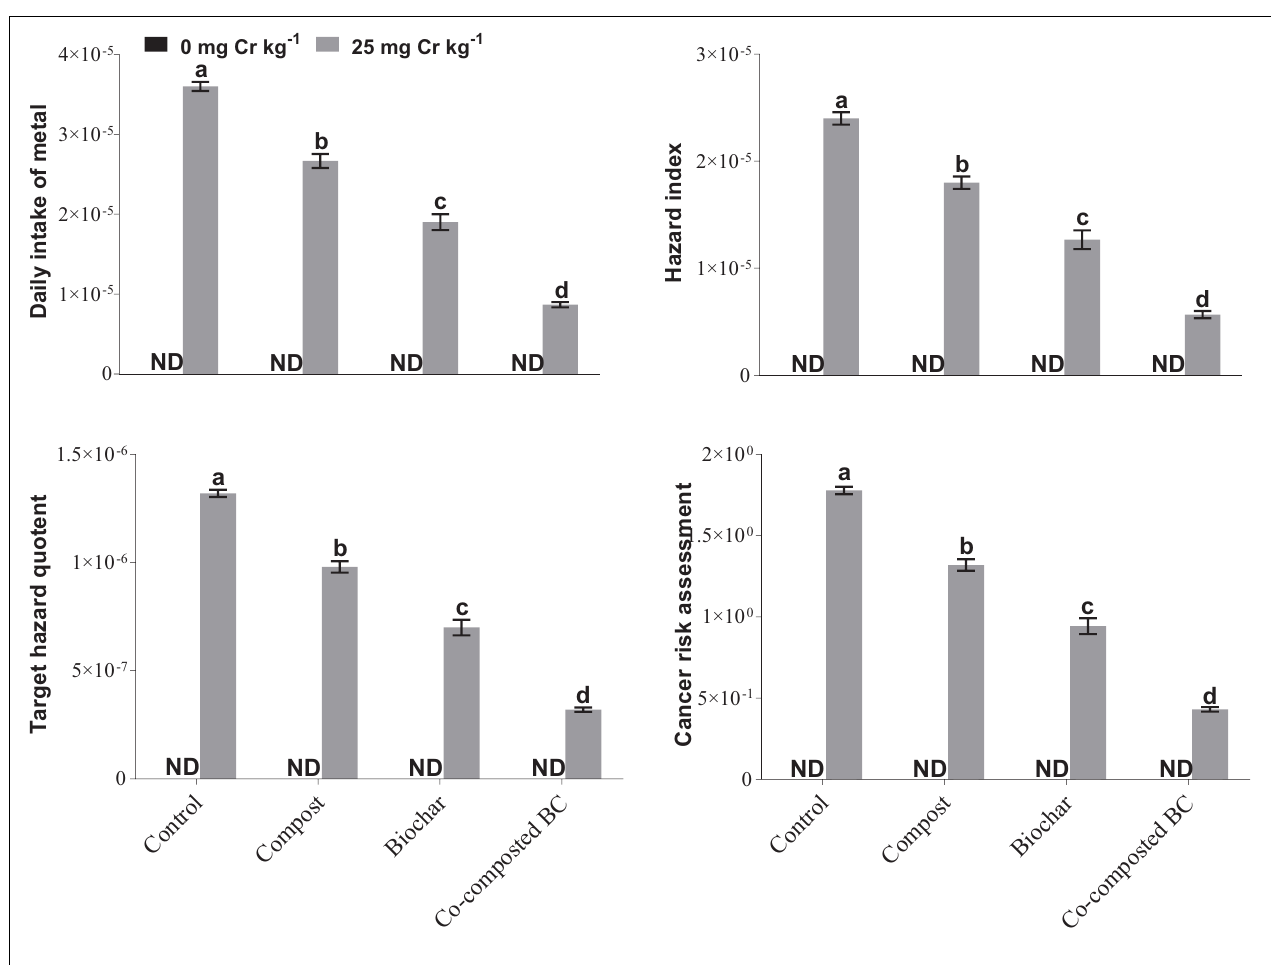
FIGURE 8 | Impact of compost, biochar, and co-composted biochar on health risk assessment for the accumulation of Cr in Brassica napus . The values are presented as mean ± standard error ( n = 3). The values sharing the same letter(s) in bars are statistically non-significant with each other at p <